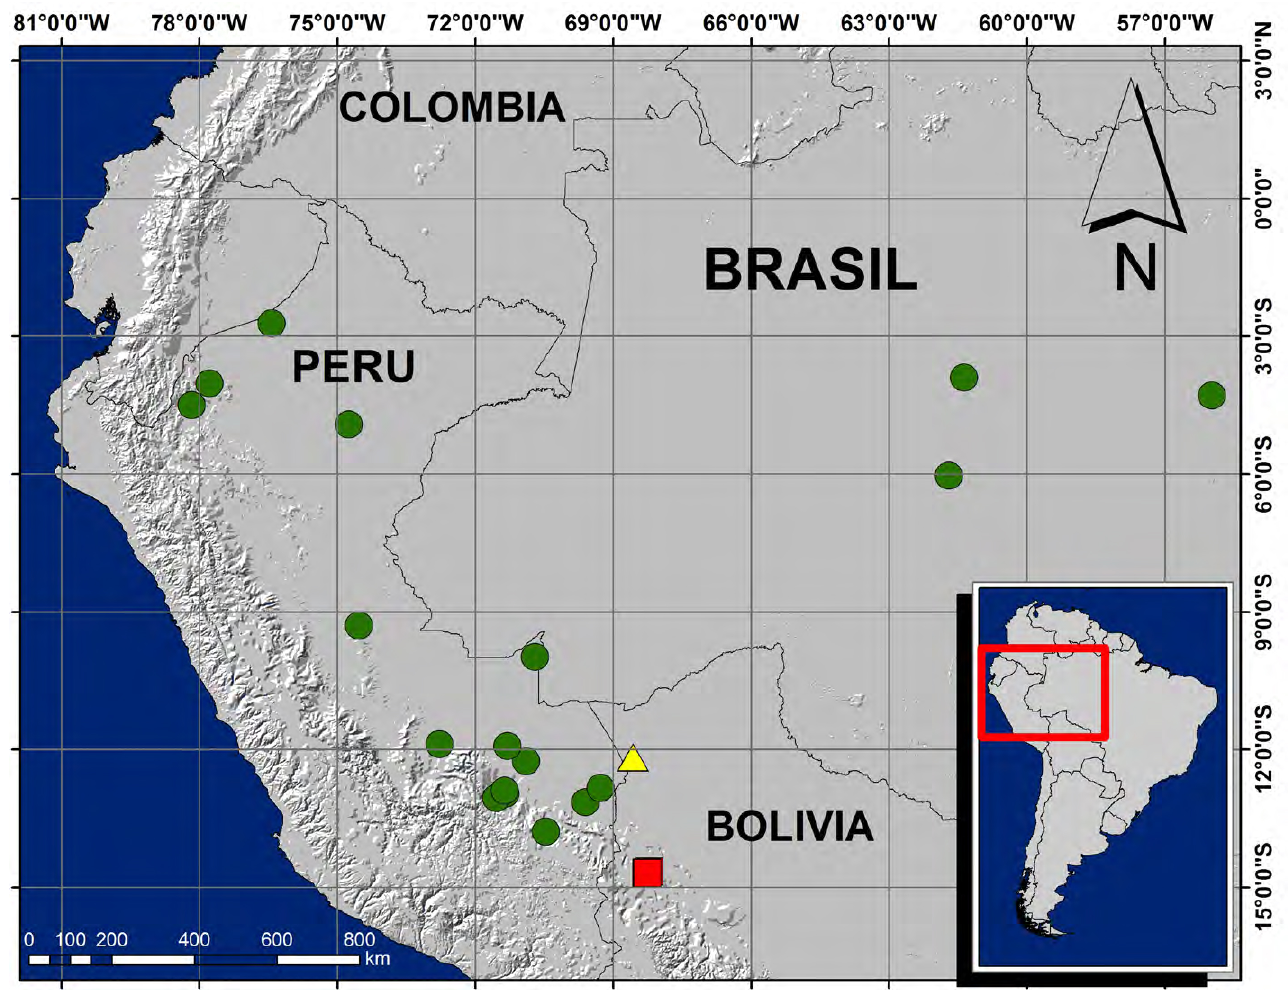
Figure 2. Distribution map for Pristimantis ockendeni in South America (WGS84), green circles from Amphibia Web 2015 omitting Ecuador records as they were described as several other species ( E lmEr & C annatElla 2008), the yellow triangle represents the first Bolivian record ( P adial et al. 2004), and the red square is the new southernmost record described